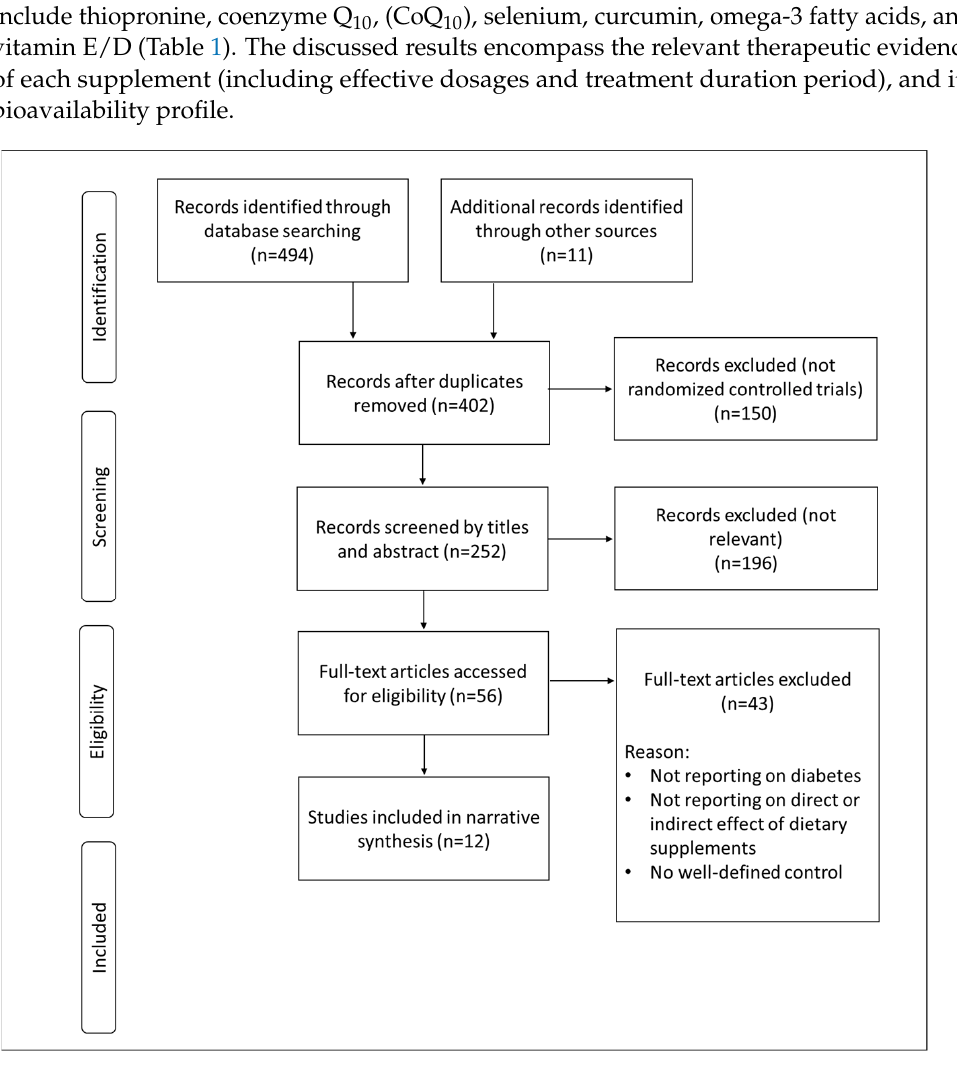
Figure 2. An overview of the flow diagram representing study inclusion.